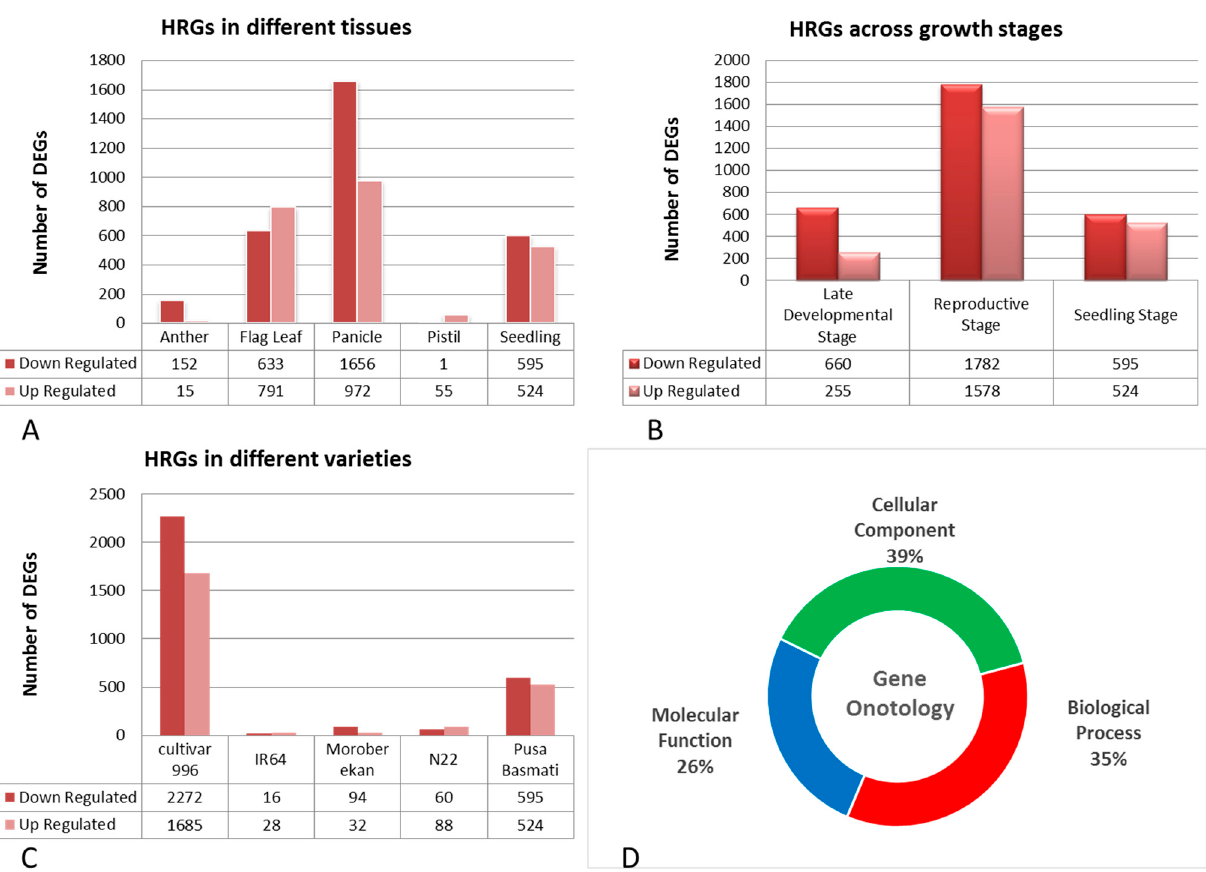
Figure 3. Meta-analysis of rice microarray datasets across different stages and tissues under heat stress. ( A ) Tissue-specific heat stress-responsive genes; ( B ) developmental-stage-specific heat stress-responsive genes; ( C ) genotype-specific heat stress-responsive genes; ( D ) Gene Ontology of the differentially expressed genes (DEGs).